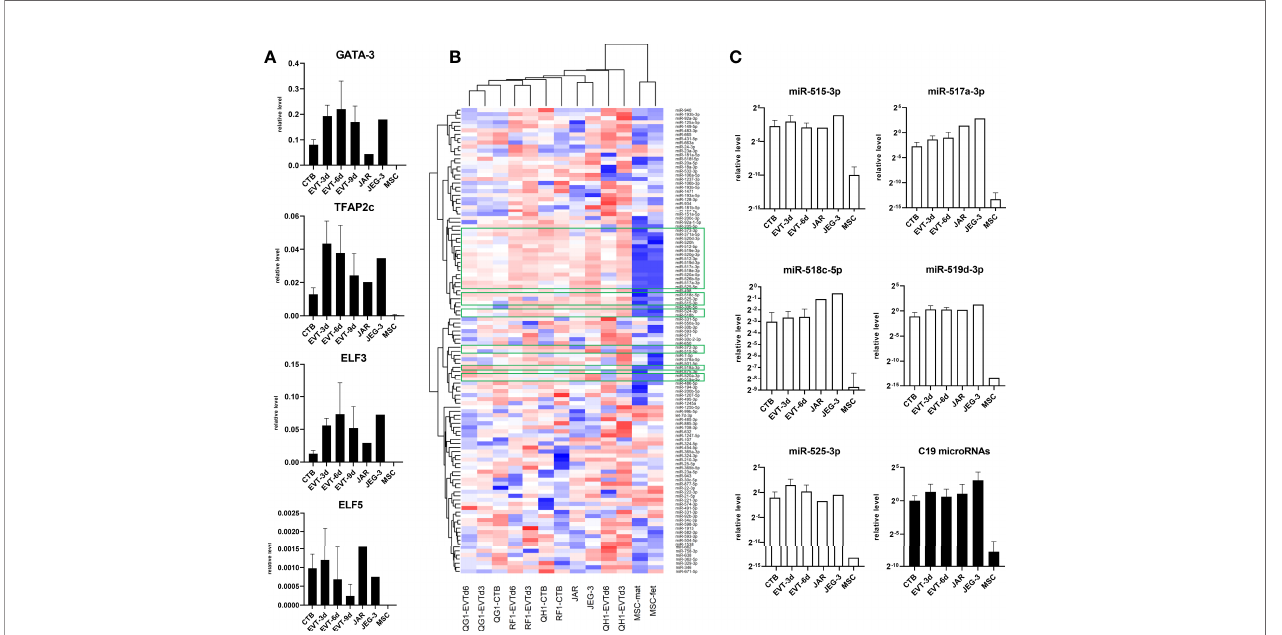
FIGURE 3 | Expression of classical trophoblast markers in primary trophoblast cultures. (A) Messenger RNA expression of GATA3, TFAP2c, ELF3, and ELF5 (n = 6 primary cultures; n = 2 MSC cultures). (B) Approximately 750 microRNA were screened in primary CTB/EVT (n = 3), along with JAR, JEG-3, and two MSC lines. Out of these, 116 microRNAs were included for hierarchical clustering. Twenty- fi ve C19 microRNA (green boxes) were typically expressed in trophoblasts. (C) Expression level of fi ve typical C19 microRNAs (open bars) and average level of all C19 microRNAs per group (black bars). All graphs are represented by means with